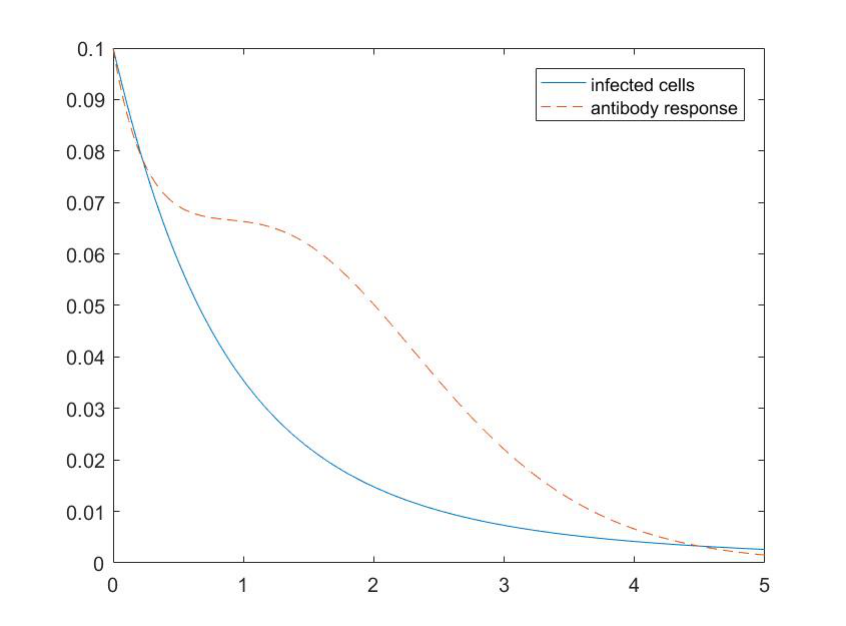
Figure 3. Infected cells and Antibody